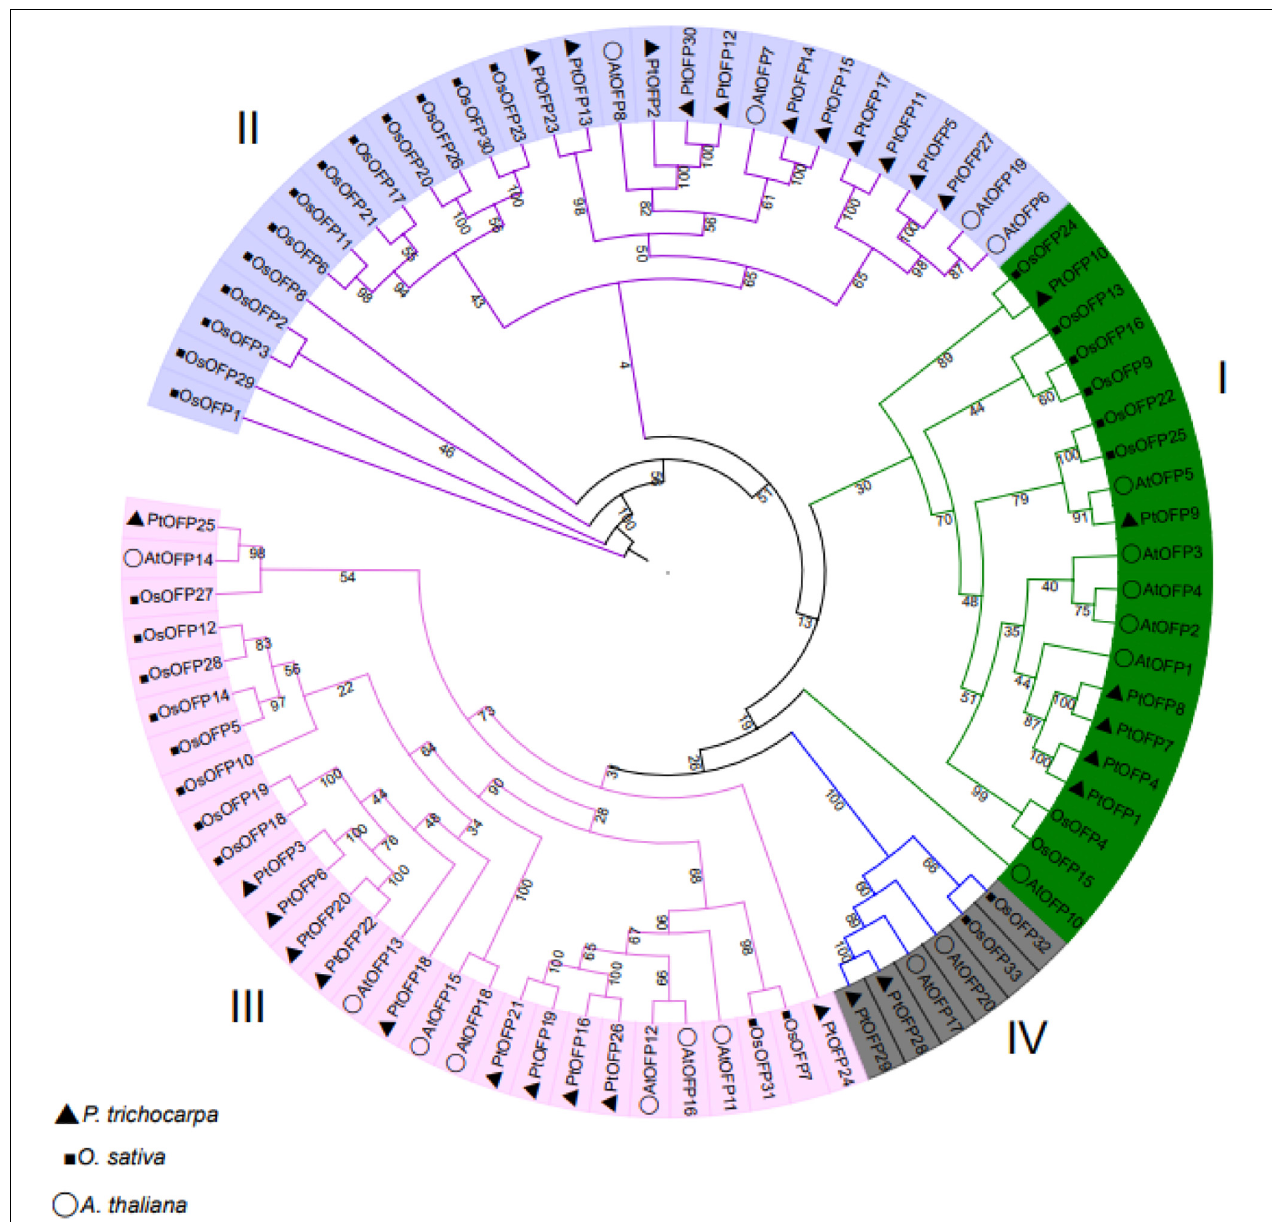
FIGURE 1 | Phylogenetic analysis of OFPs in A. thaliana, O. sativa , and P. trichocarpa. A. thaliana , O. sativa , and P. trichocarpa OFPs were aligned using ClustalX, and the tree were constructed by using the neighbor-joining (NJ) method with MEGA 7.0. The tree was divided into four subfamilies according to bootstrap support values and evolutionary distances. The bootstrap analysis was performed using 1000